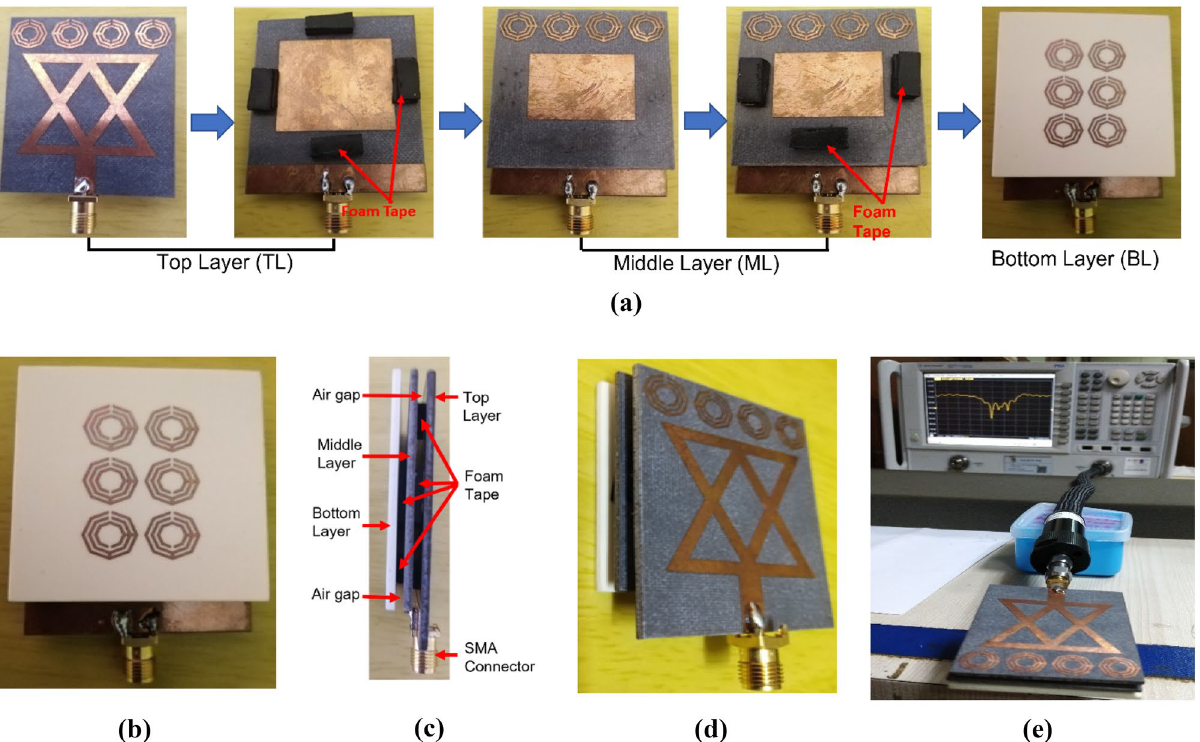
Figure 8. Fabricated proposed antenna and measurement: ( a ) Antenna fabrication steps; ( b ) Back view of completed antenna; ( c ) Side view of completed antenna; ( d ) Perspective view of completed antenna; ( e ) Antenna measurement by PNA.